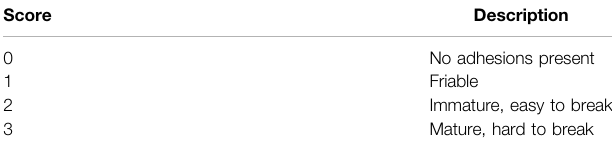
TABLE 2 | Adhesion strength